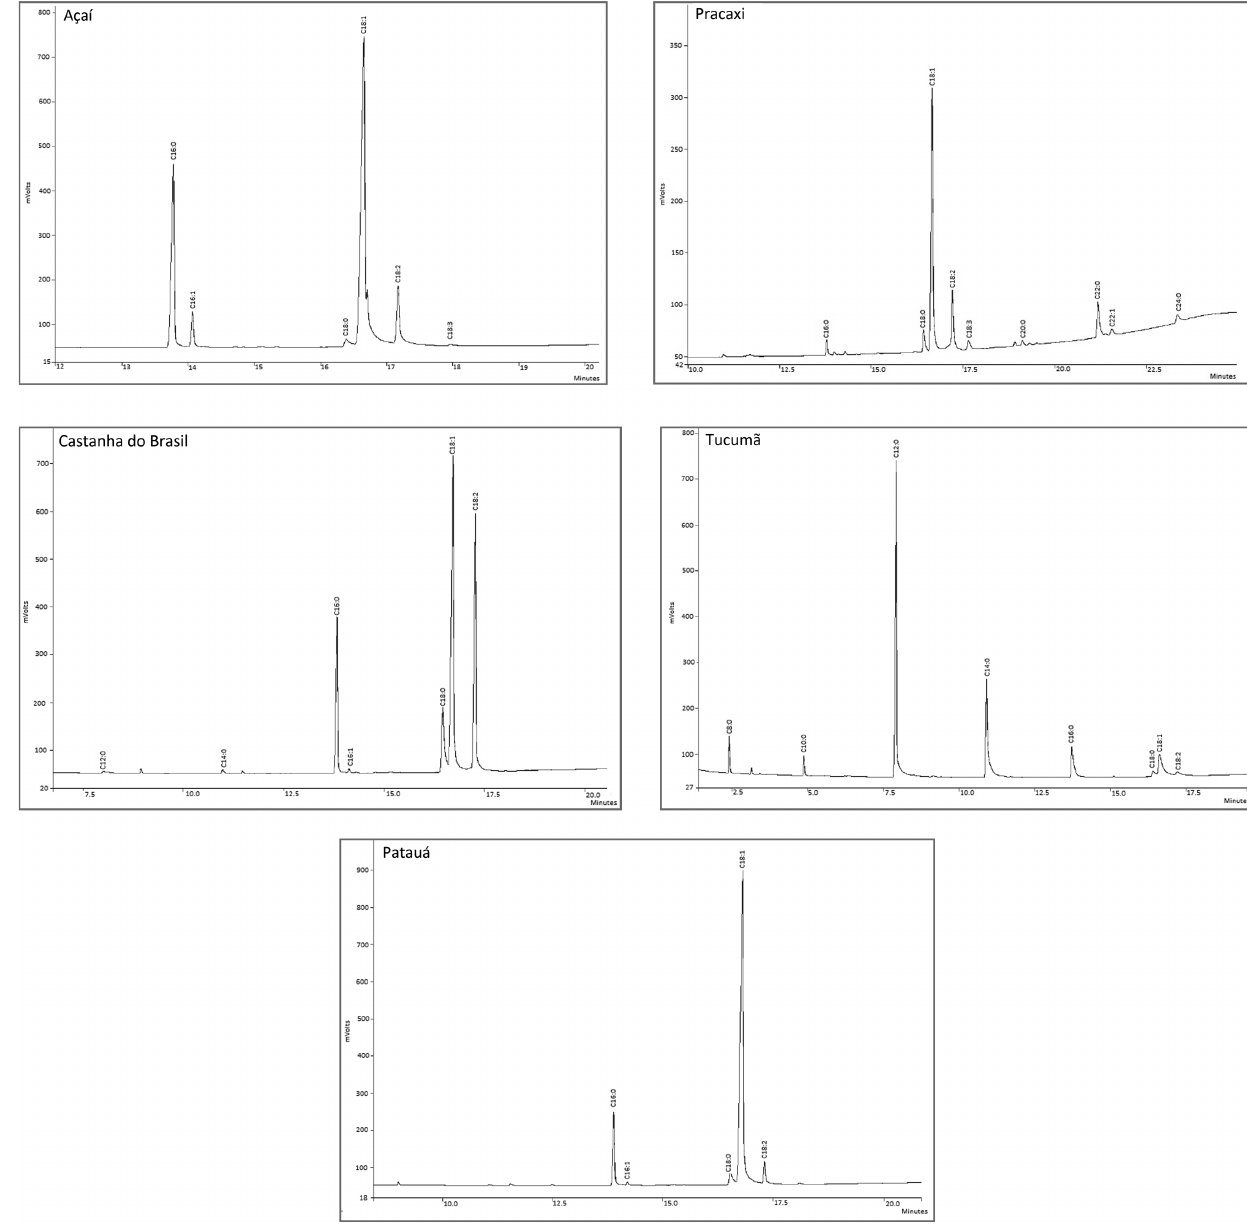
FIGURE 1 - Gas chromatograms of the studied Amazonian oils. Acids: C12:0 – lauric; C14:0 – myristic; C16:0 – palmitic; C16:1 – palmitoleic; C18:0 – stearic; C18:1 – oleic; C18:2 – linoleic; C18:3 – linolenic; C20:0 – arachidic; C22:1 – erucid; C24:0 –